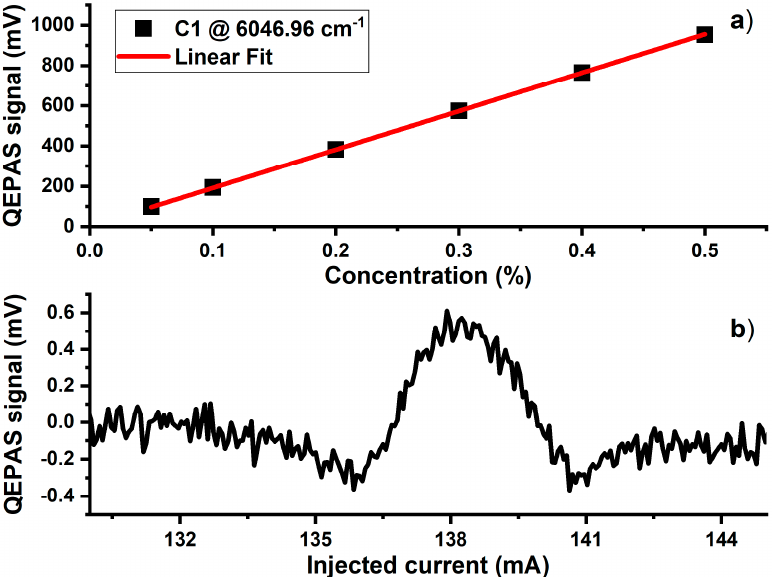
Figure 5. ( a ) Linearity of the 2f methane peak signal in the concentration range 0.05–0.5% in mixtures containing both C2 and N 2 . The uncertainty of the measured data points lies within the size of the depicted data point symbols. ( b ) 2f C1 QEPAS signal in the LD1 range measured for a standard-air mixture containing 1.9 ppm of methane.